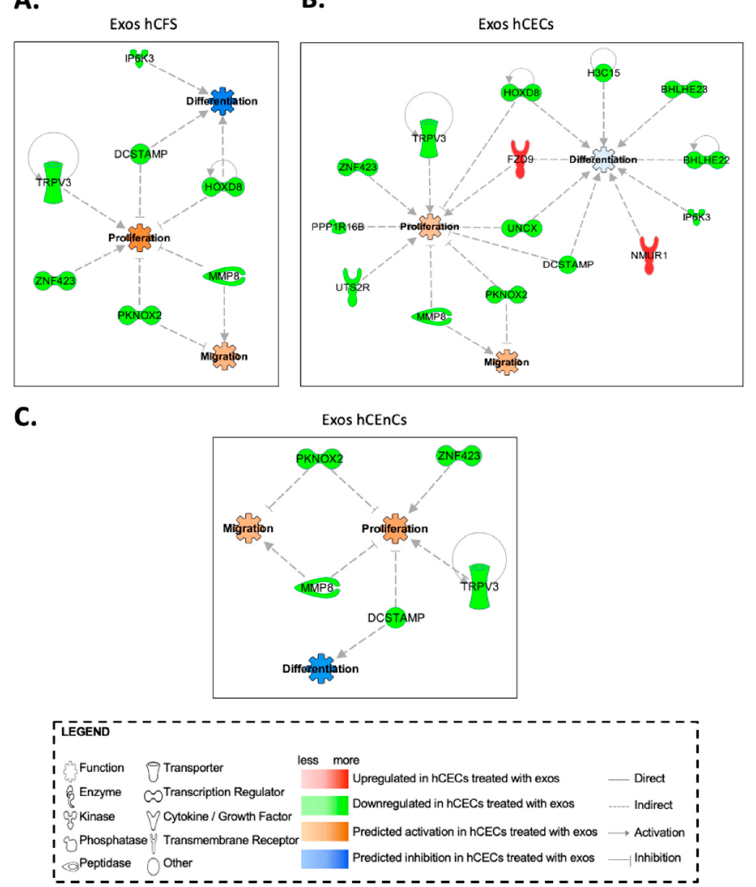
Figure 8. IPA generated interactome derived from differentially expressed genes in hCECs when supplemented with hCFs—( A ), hCECs—( B ) and hCEnCs—( C ) exosomes. Computationally predicted biological functions of interest (proliferation, migration and differentiation) are identified with